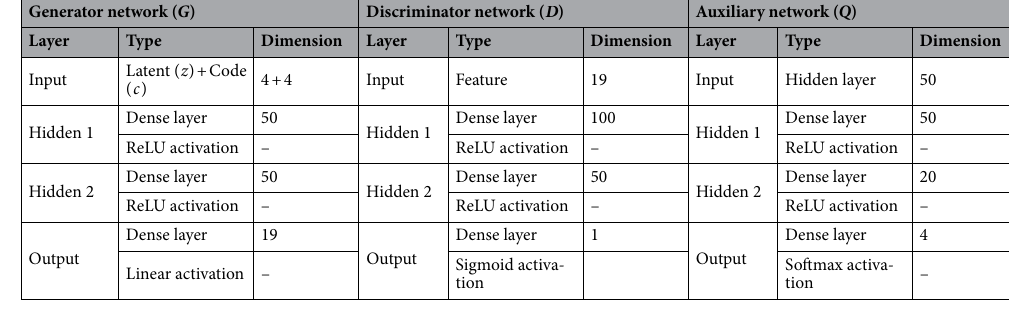
Table 4. The proposed InfoGAN structure. Each network holds two hidden layers but with a varying number of nodes. Input to the auxiliary network is the output of the second hidden layer in the